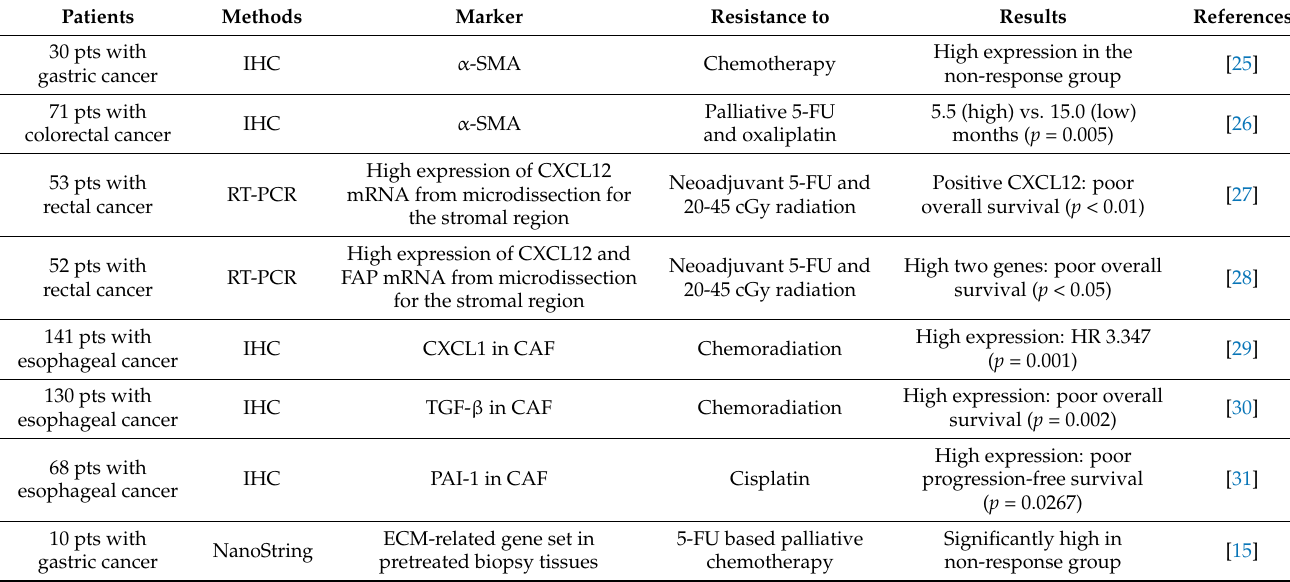
Table 1. Clinical studies investigating the role of CAFs in resistance to chemotherapy and radiation therapy in gastrointestinal